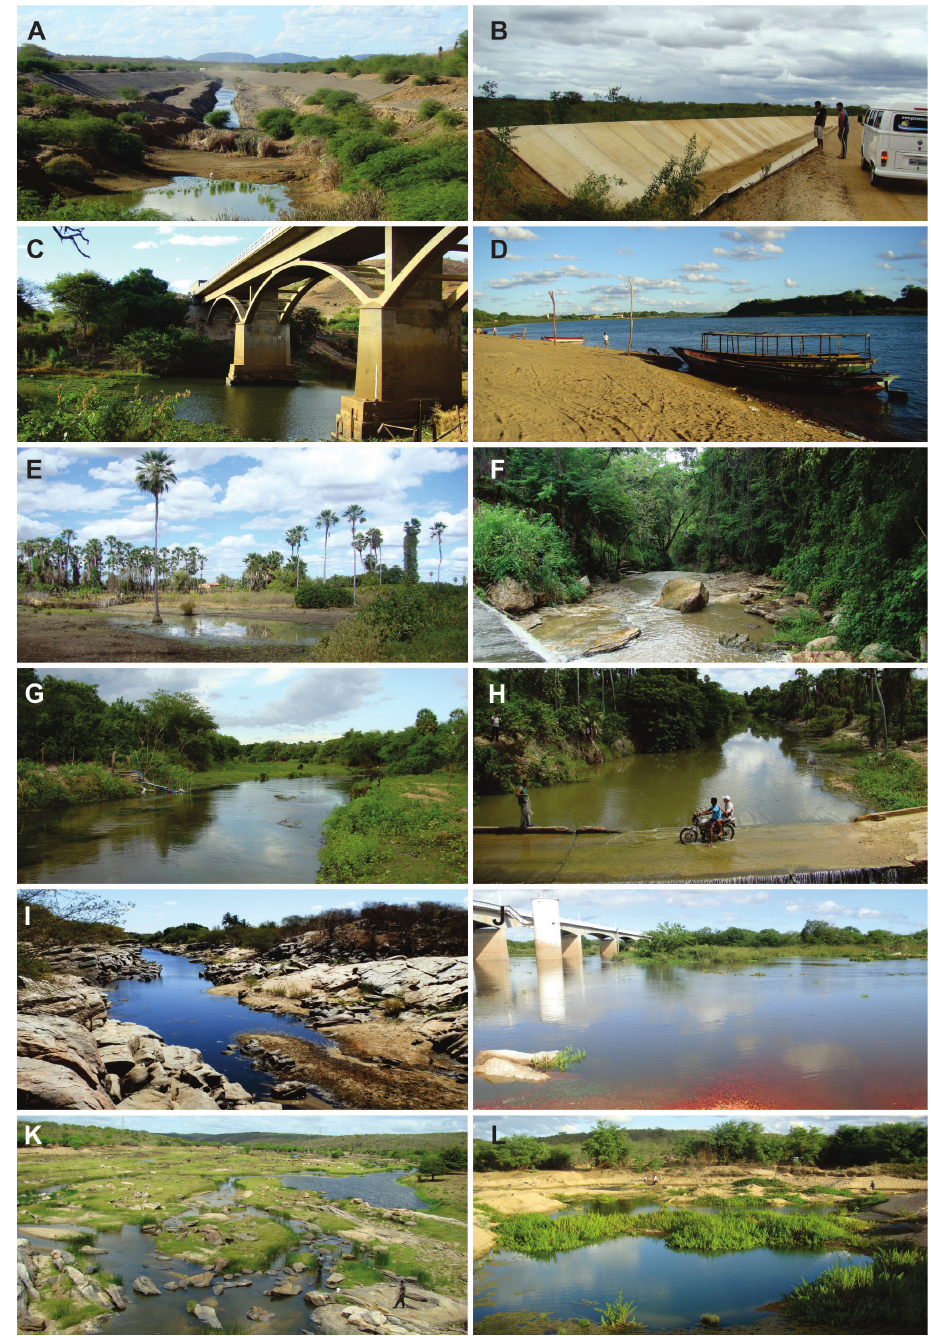
FIGURE 2 | Sampling sites in the São Francisco Interbasin Water Transfer Project basins in the Brazilian semiarid. A = Canals under construction near the rio São Francisco main channel, and B = near Sertânia, Pernambuco State (PE), C = Rio Pajeú, tributary of the São Francisco basin, PE, D = Rio São Francisco near Petrolina, PE, E = Temporary pool in rio Jaguaribe basin in Russas, Ceará State (CE), F = Rio Jaguaribe in Crato, CE, G = Rio Apodi-Mossoró in Pau dos Ferros, Rio Grande do Norte State (RN), H = Rio Apodi-Mossoró in Pau dos Ferros, RN, I = Rio Seridó, tributary of the Piranhas-Açu basin in Caicó, RN, J = Rio Piranhas-Açu, Jardim de Piranhas, RN, K = Rio Paraíba do Norte in Barra de Santana, Paraíba State (PB), L = Rio Paraíba do Norte in São João do Cariri,